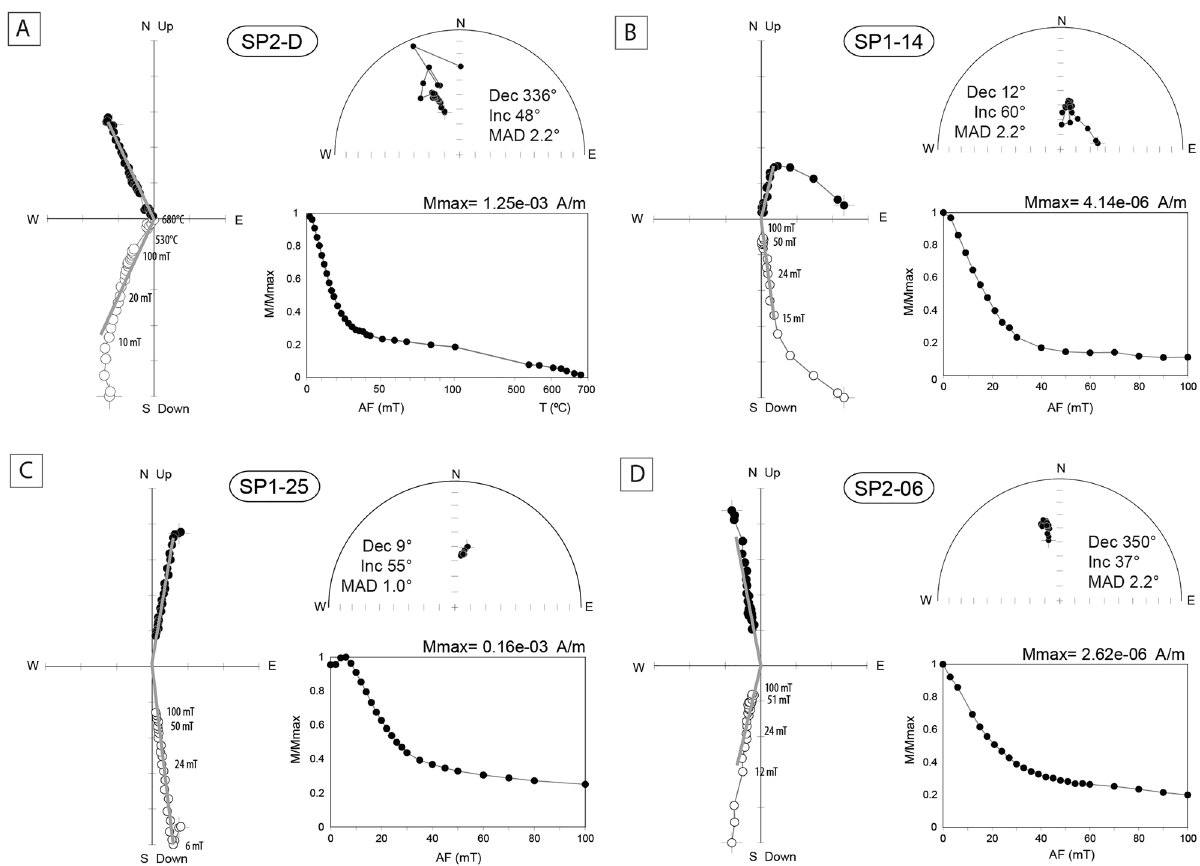
Figure 3. Stereographic and orthogonal projections and remanence intensities versus alternating field (AF) and temperature of representative SP samples. Grey lines in the orthogonal plot represent the vector of the characteristic remanent magnetization